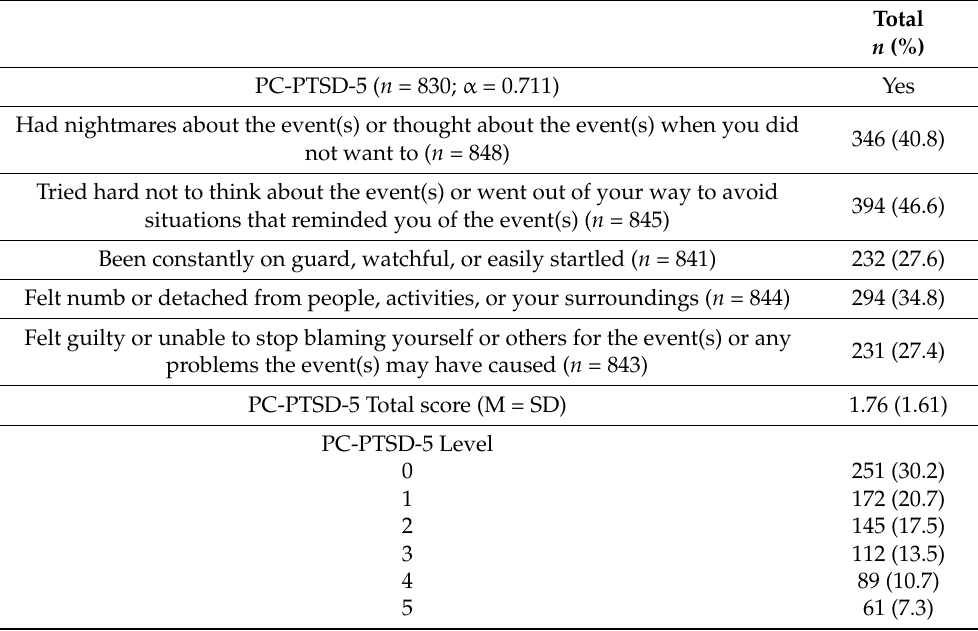
Table 2. Post-traumatic stress disorder during the first wave of COVID-19.